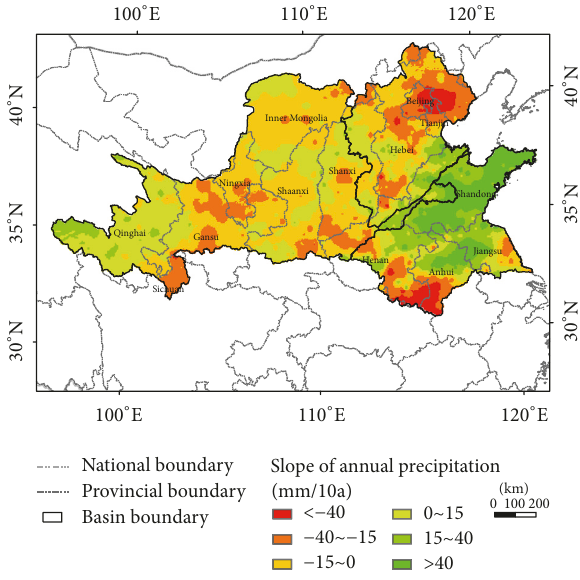
Figure 7: Rate of change in precipitation from 1982 to